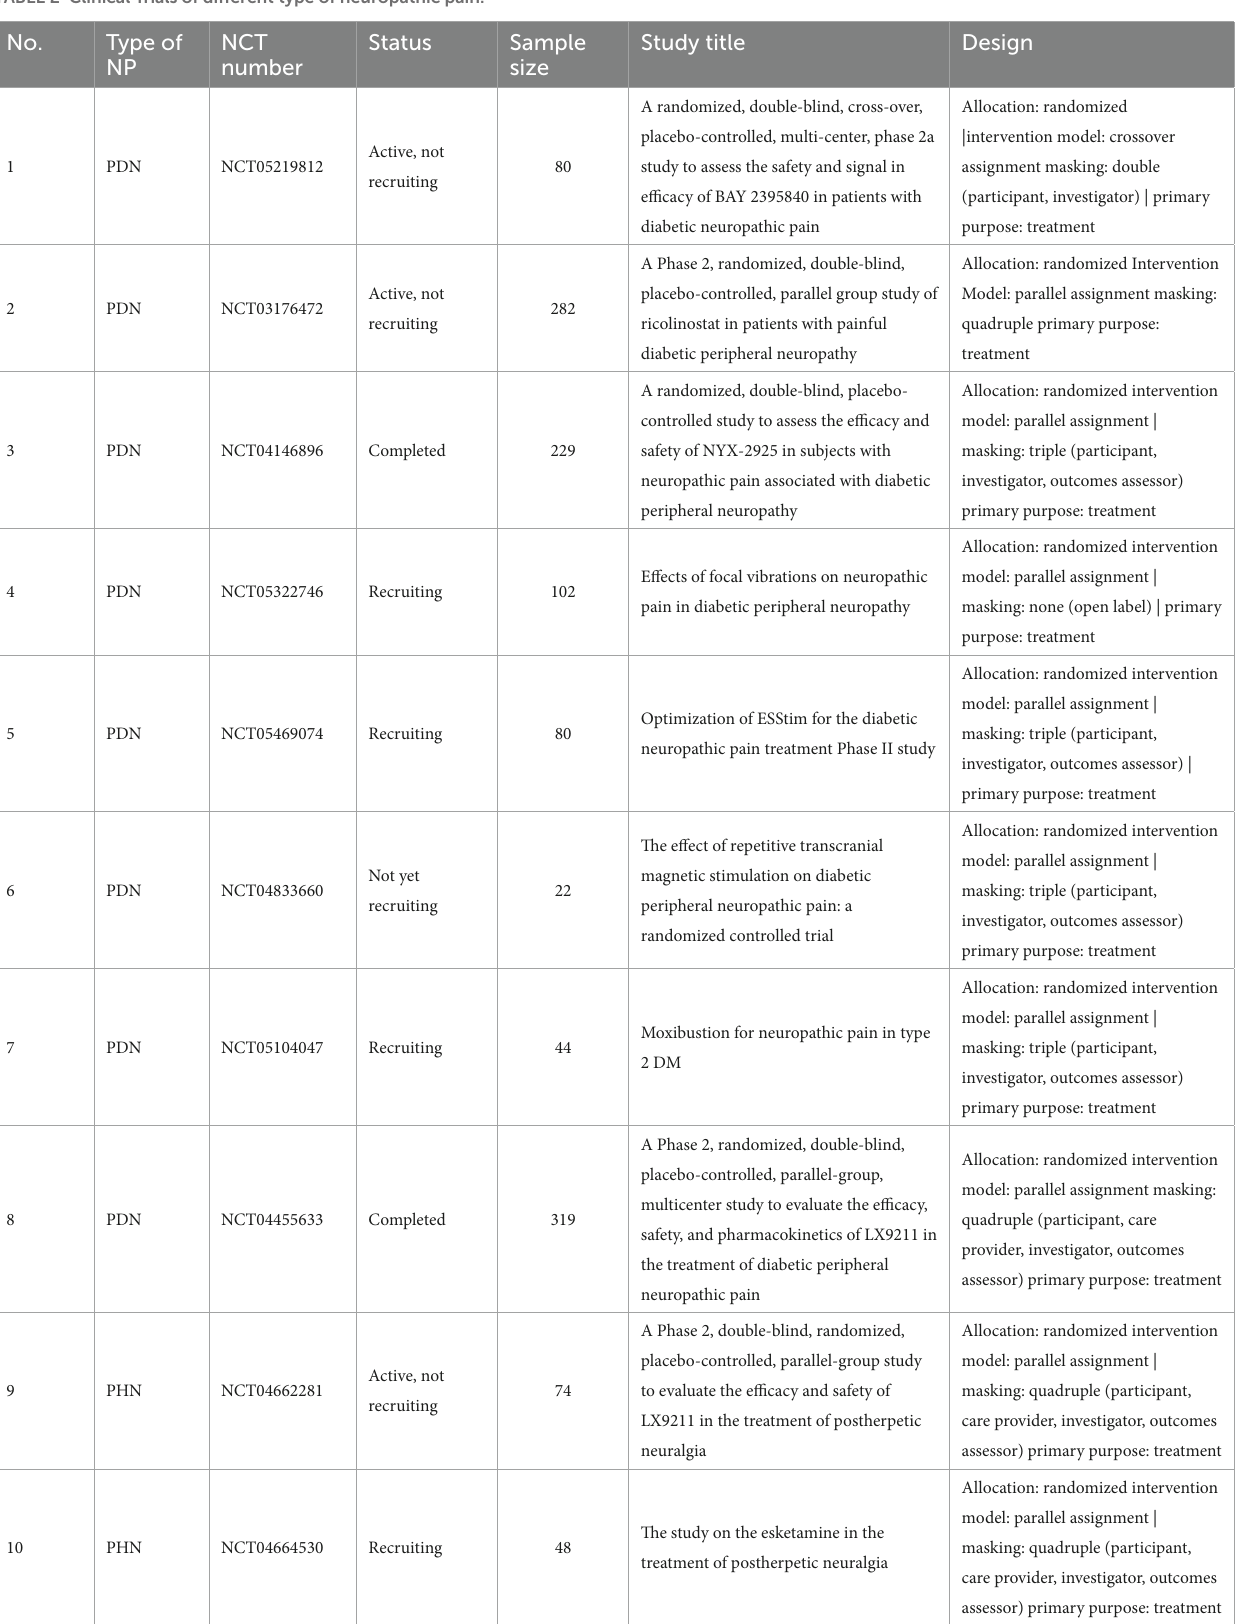
TABLE 2 Clinical Trials of different type of neuropathic pain.